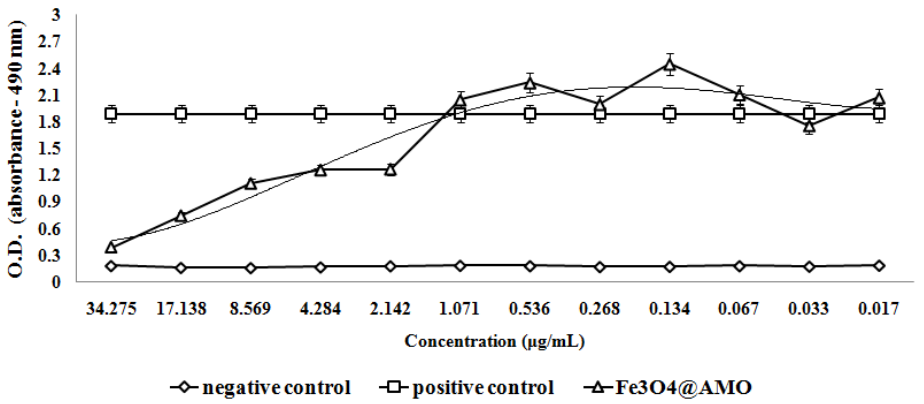
Figure 10. The effect of Fe 24 h of